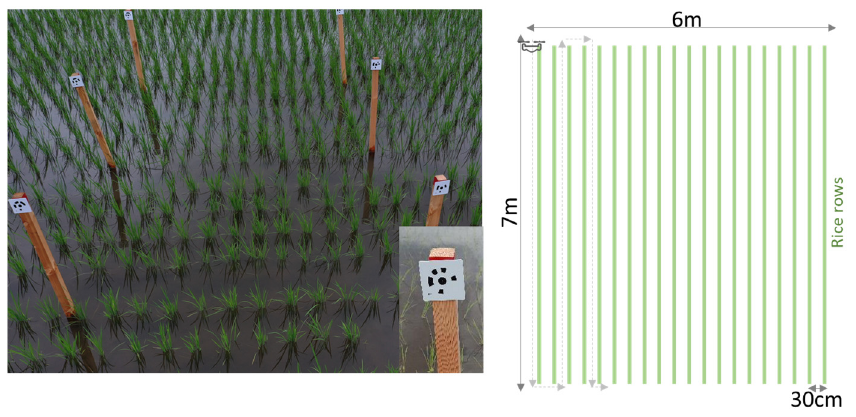
Figure 2. Experimental field. (Dotted arrows indicate flight